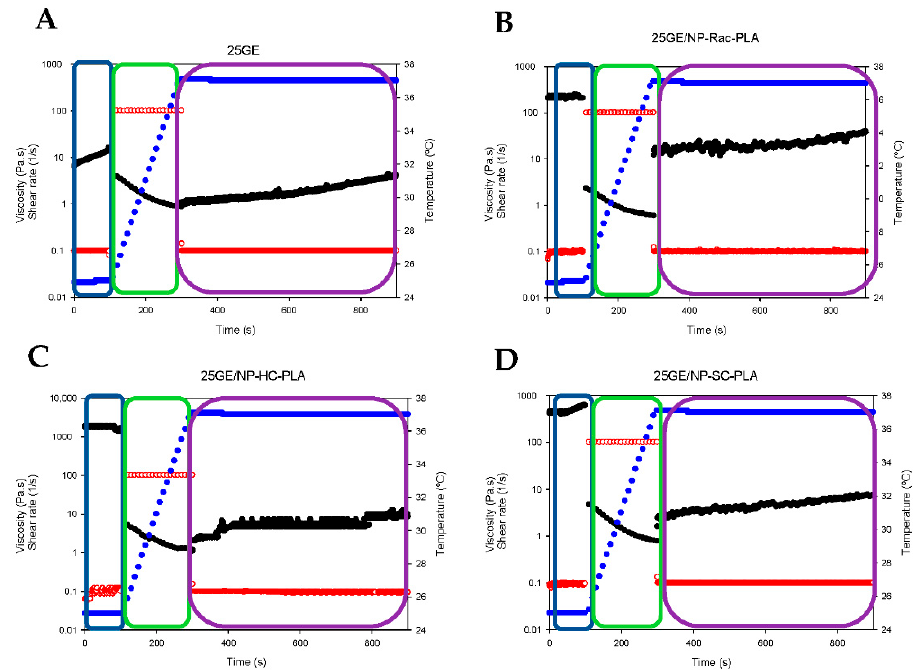
Figure 8. Syringe test results of gelatin hydrogel ( A ), GE/NP-Rac-PLA/DOX ( B ), GE/NP-HC- PLA/DOX ( C ) and GE/NP-SC-PLA/DOX ( D ). Viscosity (black color), shear rate (red color), temper- ature (blue color).